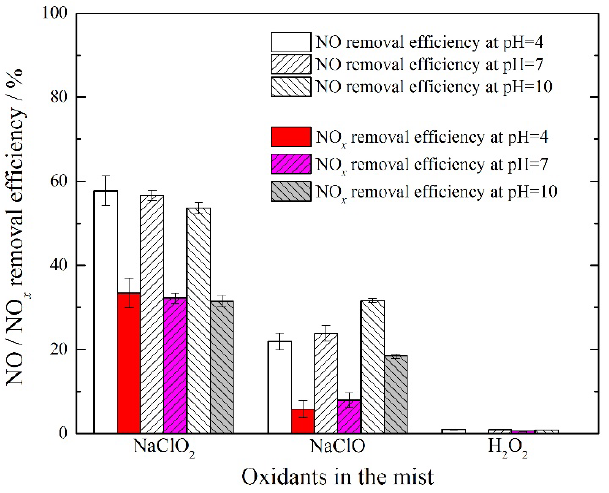
Figure 2. The change of NO removal efficiencies with different oxidants in mist.